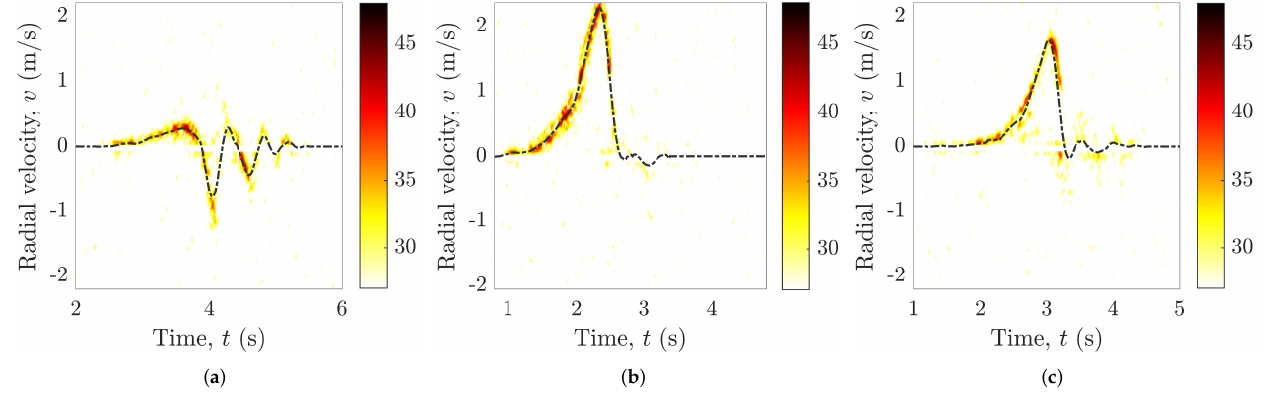
Figure 8. For Radar 2 , the measured radial velocity distribution p 22 ( v , t ) and mean radial veloc- ity ¯ v 22 ( t ) of a human falling activity in ( a ) Scenario 1, ( b ) Scenario 2, and ( c ) Scenario 3.